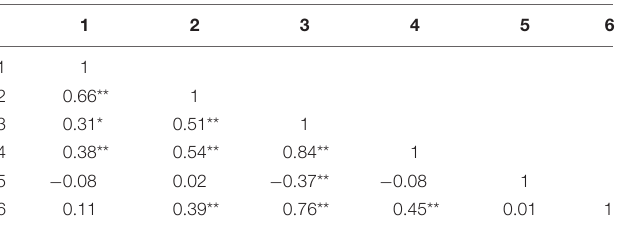
TABLE 3 | Pearson correlation matrix for mindfulness, spirituality, and SWB (post-assessment of mandala